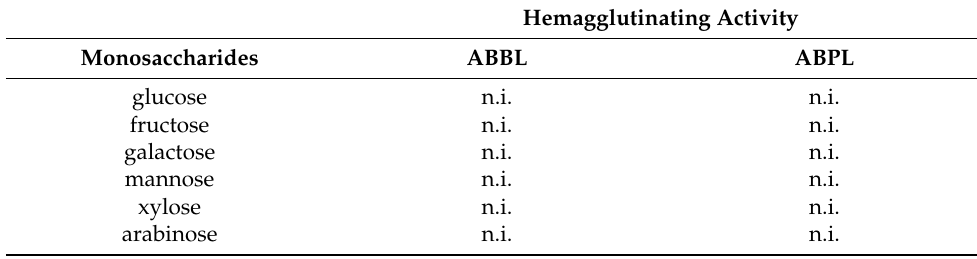
Table 4. Effect of carbohydrates on the hemagglutination activity of the lectins of two varieties of Phaseolus coccineus